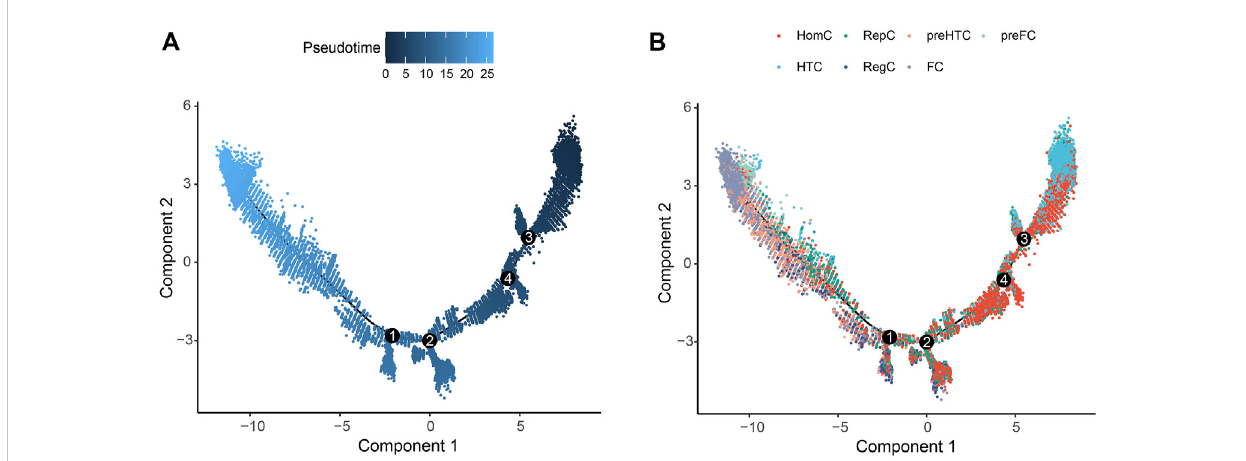
FIGURE 3 Pseudo-temporal trajectory revealing the chondrocyte progression. (A) Pseudo-time progression diagram with color from dark to light indicating the pseudo-time order. (B) Pseudo-temporal map of chondrocytes colored according to cell subtype. The horizontal and vertical axes represent two principalcomponents.Eachdotindicatesasinglecell,andthedigitinthecirclerepresentsthepredictednodesofthedifferentcellstatesinthetrajectory.